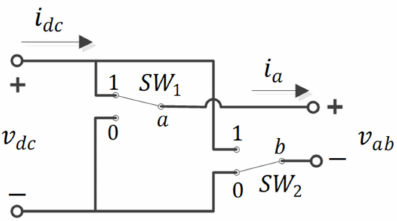
Figure 3. H full bridge converter simplified circuit using SPDT switches.